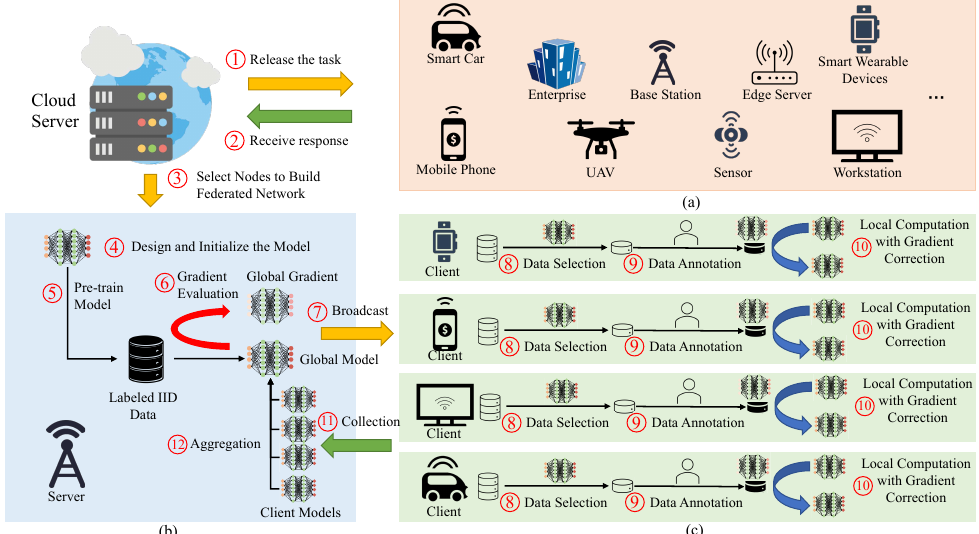
Figure 1. Semi-Federated Active Learning Framework: ( a ) task-driven servers and client selection; ( b ) server operation; ( c ) client